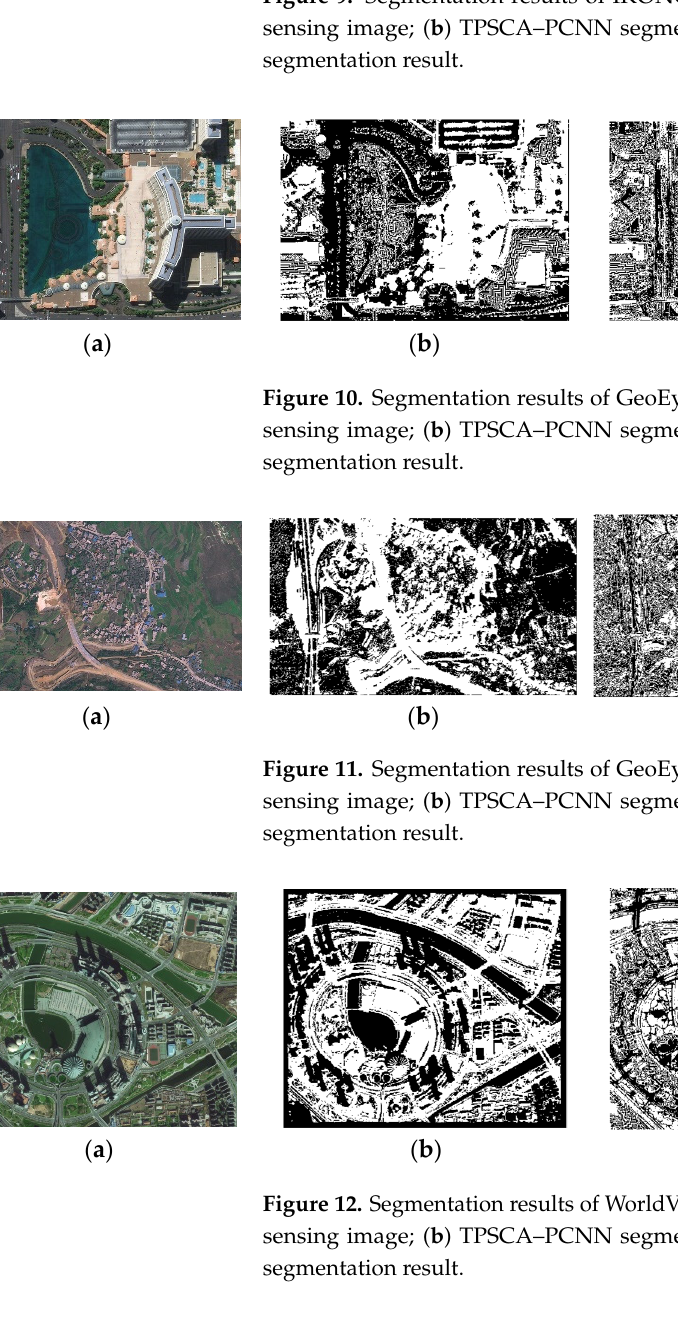
( d ) Figure 13. Segmentation results of WorldView-2 satellite remote sensing image 6: ( a ) original remote sensing image; ( b ) TPSCA–PCNN segmentation result; ( c ) PCNN segmentation result; ( d ) EML seg- mentation result. Table 10. The experimental results of image segmentation using TPSCA–PCNN, PCNN, and ELM. Dataset